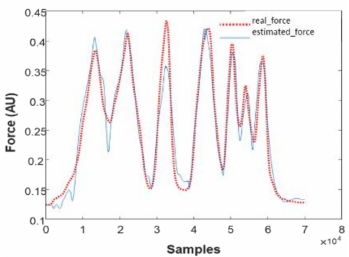
Figure 3. Responses of sub-models based on Hammerstein–Weiner structure.